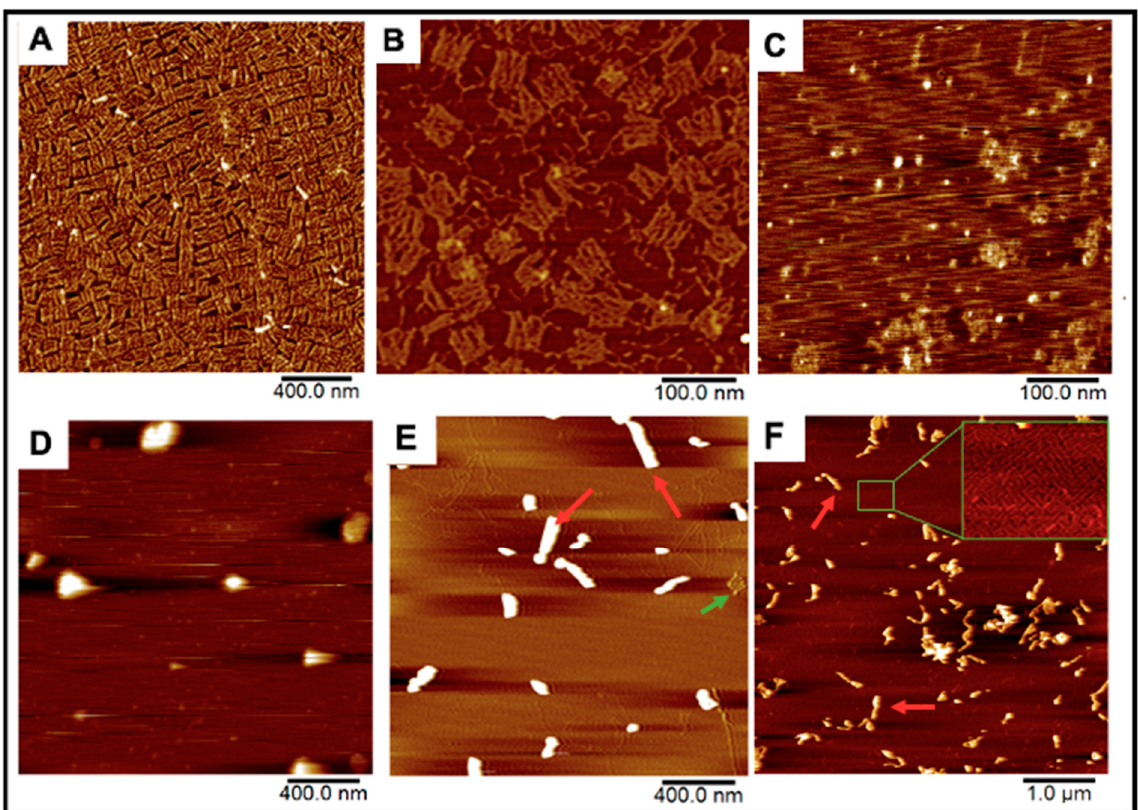
Figure 2. AFM Images of our DNA origami, HSV1 particles, and the resulting complexes after mixing. ( A , B ) Origami and folate-decorated origami sheets. Salt bi-products from formed origami were observed as seen in ( B ). ( C ) HSV1 particles ( D ) Origami:HSV1 “pockets” established at a 2:1 Origami:HSV1 molar ratio ( E ) 20:1 ratio “sleeves” and ( F ) 50:1 ratio “sleeves” where many excess sheets are left unbound. Green arrows show unbound sheets in the packing reactions while red arrows show products of the HSV1-origami “sleeve”